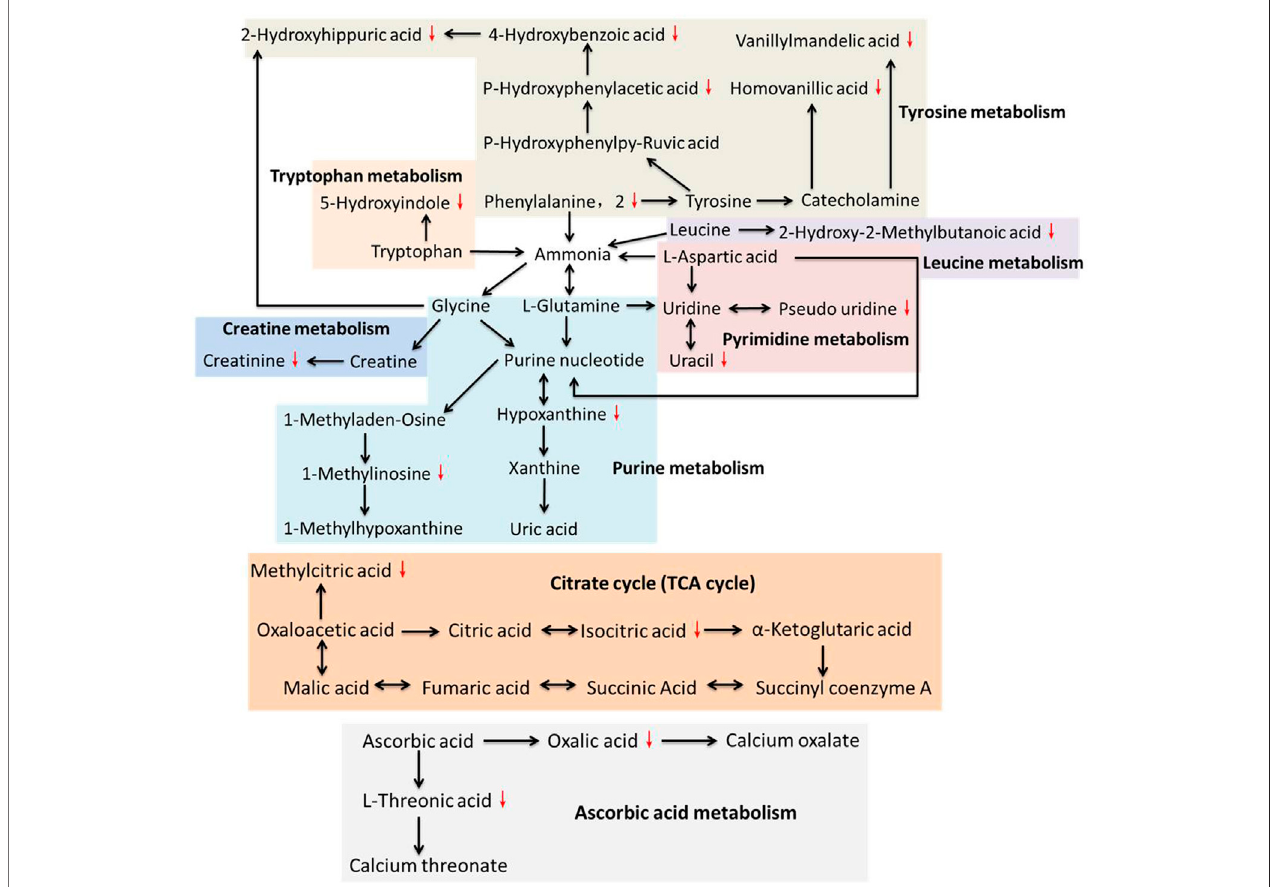
FIGURE 4 | Relationships among the principal metabolic pathways altered in the urine of LDH